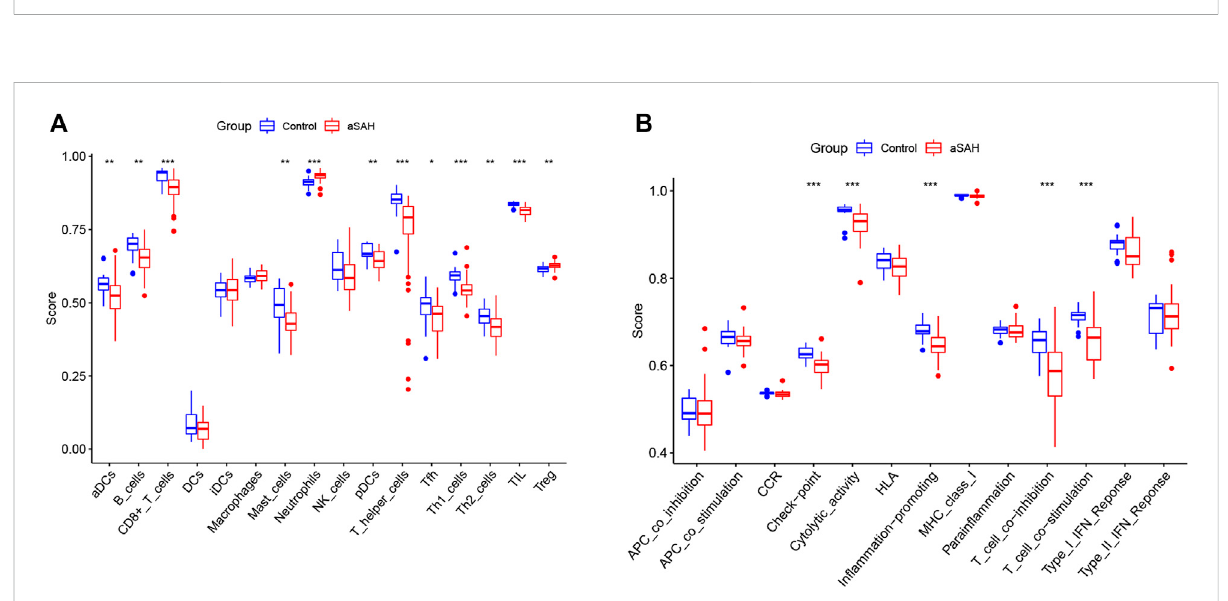
FIGURE 10 Comparisons of 22 important immune fractions by CIBERSORT. (A) The Speci fi c 22 immune fractions represented by various colors in each samplewereshown inthebarplot. (B) Heatmapofcorrelationin22 typesofimmunecells. (C) Boxplotoftheproportionof22types ofimmune cells for aSAH versus control. Immune cells that were expressed in less than half the samples were excluded. (D) Correlation matrix of all 22 immune cell subtype compositions. Red represents a positive correlation, and blue represents a negative correlation.